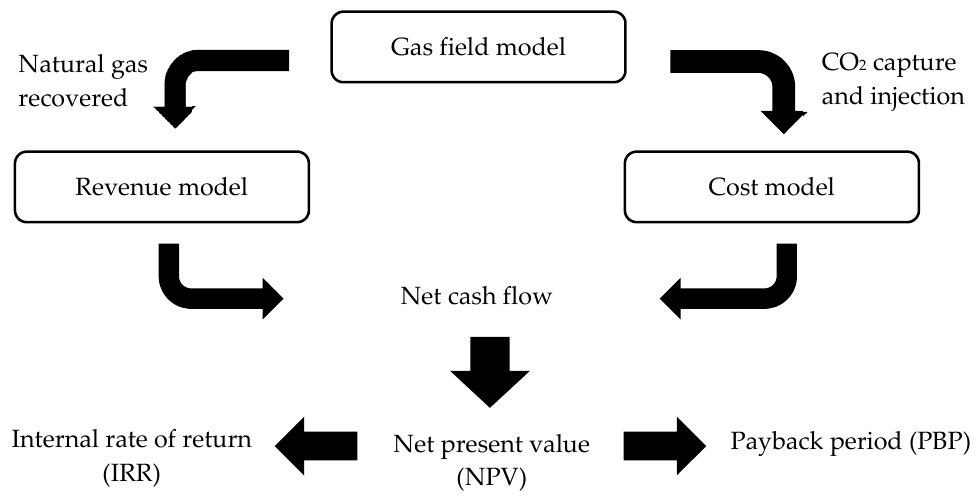
Figure 1. Schematic of the techno-economic analysis framework.